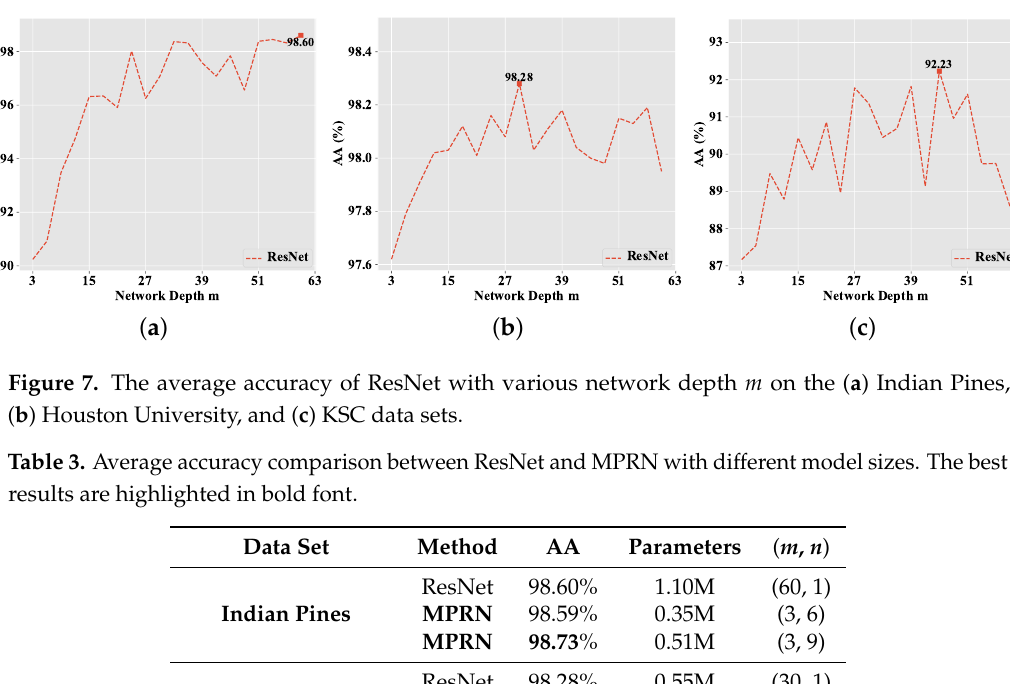
Figure 6. The average accuracy of MPRN with various network width n on the ( a ) Indian Pines, ( b ) Houston University and ( c ) KSC data sets.